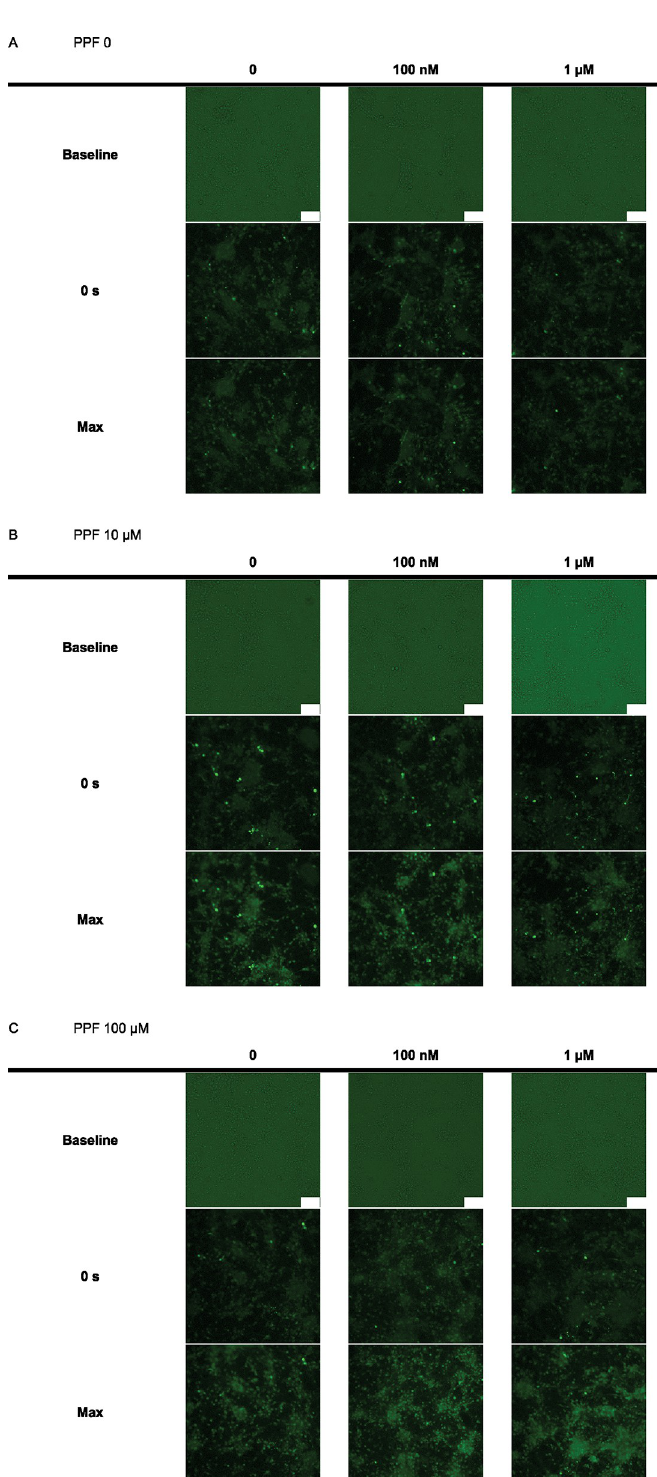
Fig 5. Images of the time course of neurons from all groups demonstrating the changes of [Ca2 +]i in response to PPF application on DIV 4. In the vehicle groups (dimethyl sulfoxide [DMSO]), the fluorescence intensities of the neurons showed little change (A), whereas in all 10 μ M (B) and 100 μ M (C) PPF exposure groups, the fluorescence intensities of neurons on DIV 4 were significantly high, and were irrelevant to PPF-PC on DIV 2. 0s: shortly before DMSO of PPF application. Max; most nearly the moment when Fmax is recorded. Since each neuron showed its own Fmax (peak moment of intracellular calcium concentration), not all the neurons showed Fmax at the same time in these images. Scale Bar = 100 μ